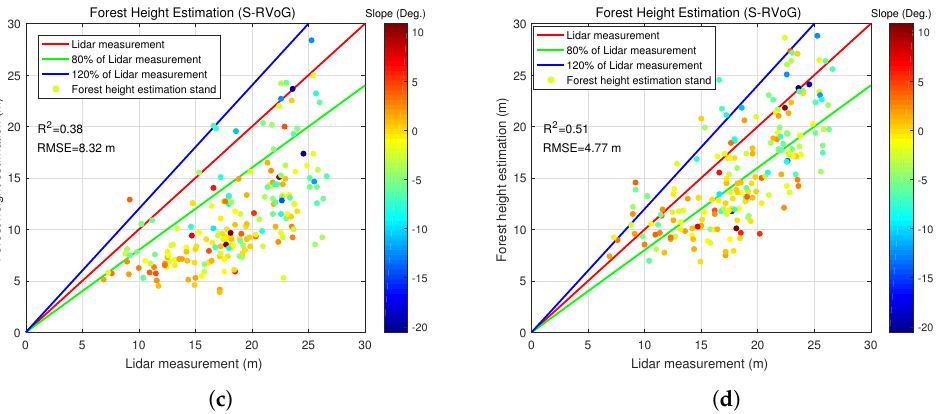
Figure 9. The forest height estimation of validation stands with ( a ) RVoG model + three-stage method, ( b ) RVoG model + modified three-stage method (time-frequency optimization), ( c ) S-RVoG model + three-stage method, and ( d ) S-RVoG model + modified three-stage method (time-frequency optimization), compared with the lidar measurement. The color of the dots represents the terrain slope.